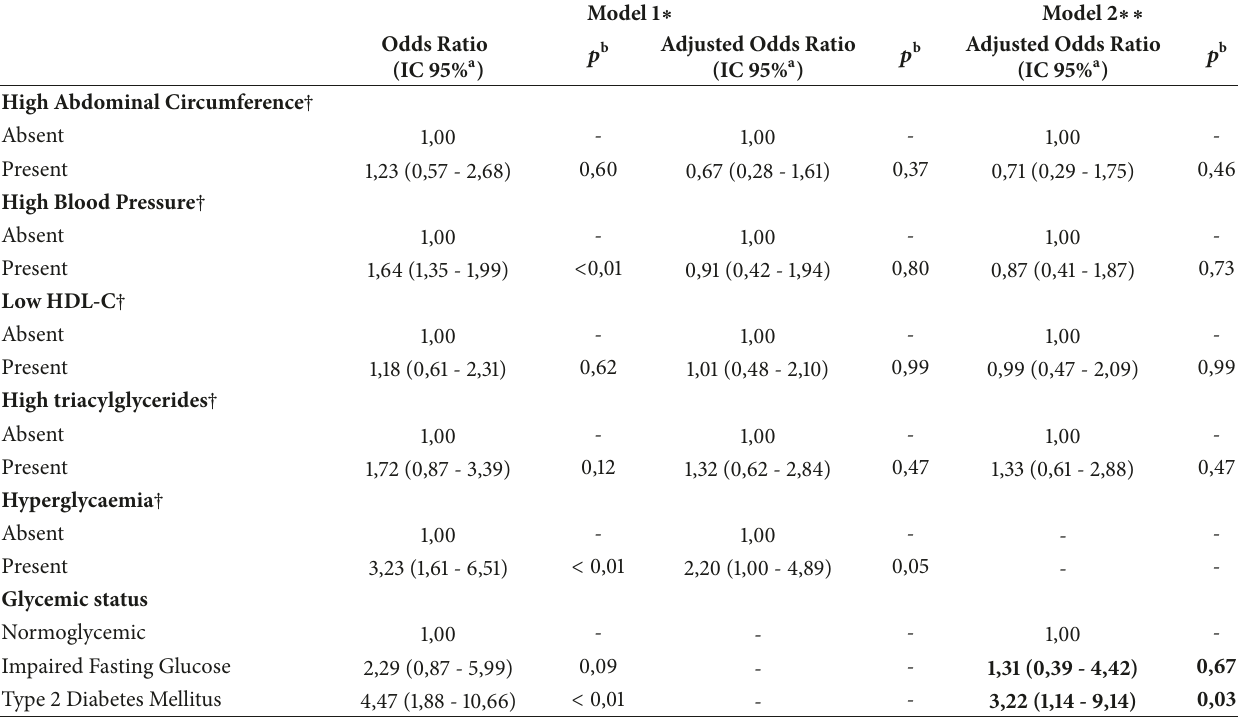
Table 4: Metabolic risk factors for subclinical hypothyroidism in adults from Maracaibo City,